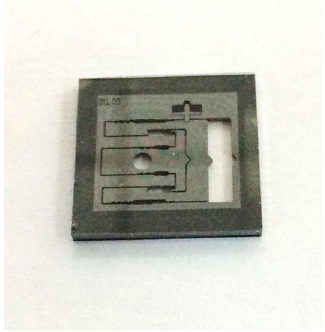
Figure 10. The silicon-based MEMS S&A device.